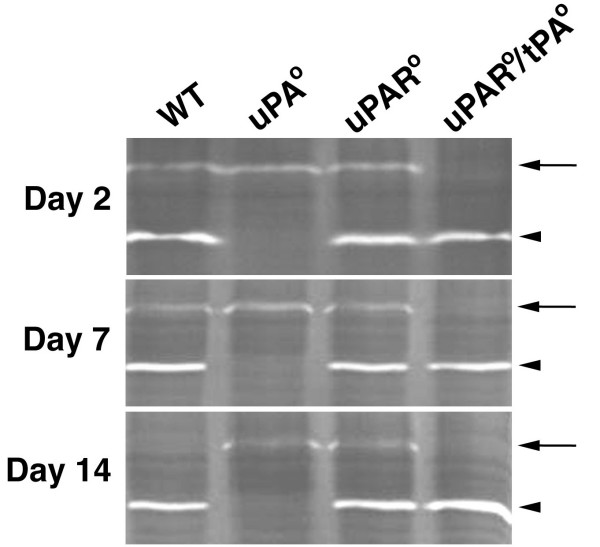
Hepatic uPA activation occurs in the absence of uPAR. Activation of uPA in the liver was observed in mice of all genotypes after CCl4, except in uPA° mice. The upper band (arrow) depicts tPA while the lower band (arrow head) depicts uPA.